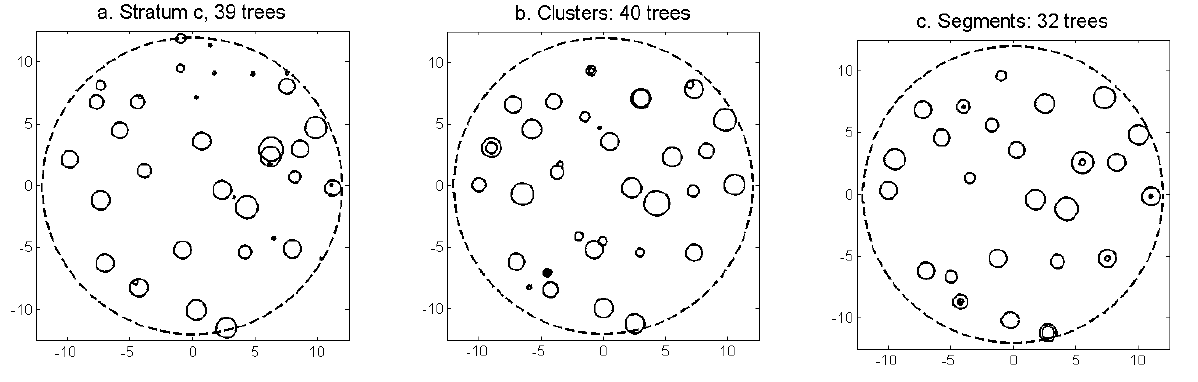
Figure 14. Examples of three field plots randomly selected from the strata defined in Table 1 with ( a ) field-measured trees in stratum c, ( b ) trees imputed from clusters in the same field plot, ( c ) trees imputed from segments in the same field plot, ( d ) field-measured trees in stratum f, ( e ) trees imputed from clusters in the same field plot, ( f ) trees imputed from segments in the same field plot, ( g ) field-measured trees in stratum i, ( h ) trees imputed from clusters in the same field plot, and ( i ) trees imputed from segments in the same field plot. The dashed lines are the borders of the 12 m radius field plots and the trees are represented by the smaller circles with diameters proportional to the